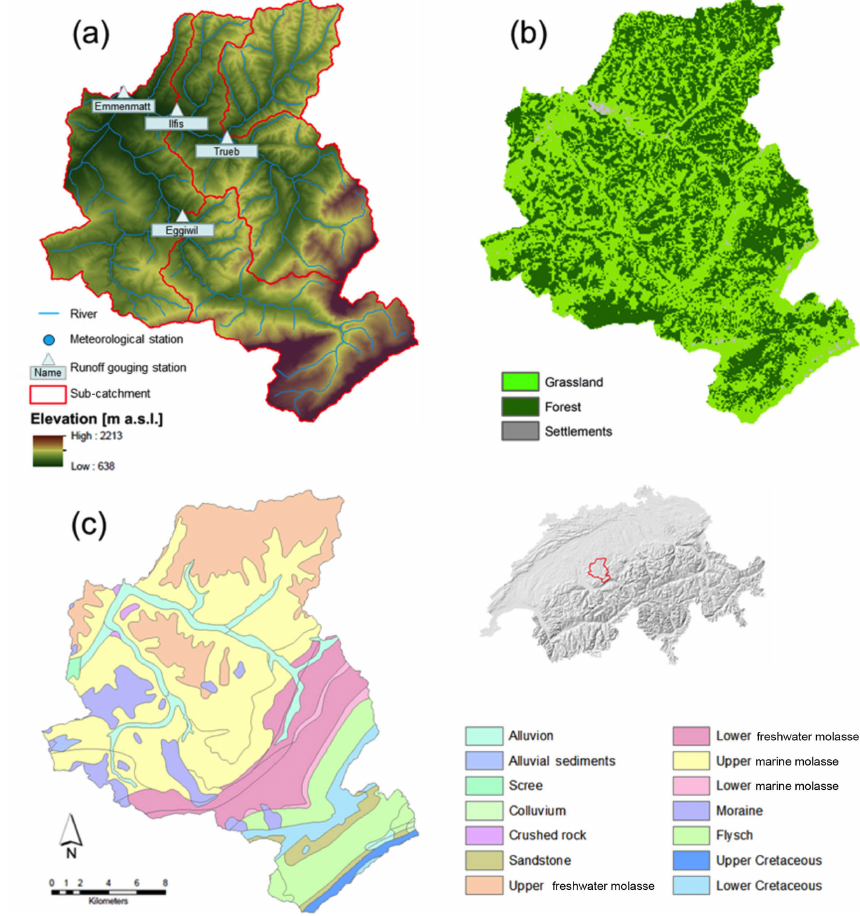
Figure 2. Maps of the Emme catchment, Switzerland. (a) Digital terrain model (25m resolution), river network, and location of the runoff gouging stations; (b) land-use map (100m resolution); (c) geology map. Data: BFS GEOSTAT/Federal Office of Topography swis- stopo